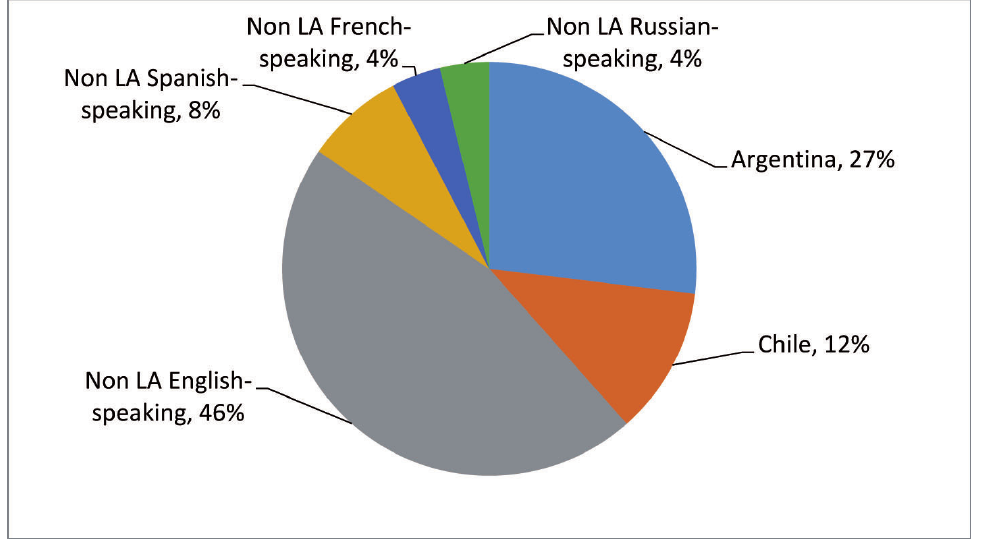
Figure 2: Distribution of origin of the top influential authors (LA = Latin American) Foreign traditions are represented by English-speaking (Van Dijk, Bazerman, Halliday,